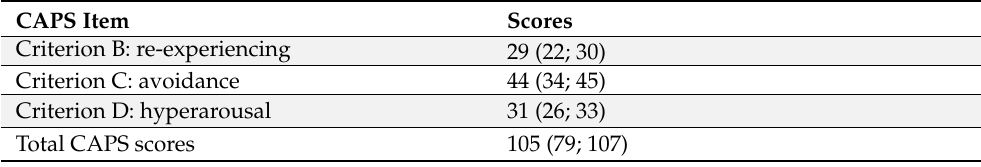
Table 1. CAPS scores in the group of war veterans with